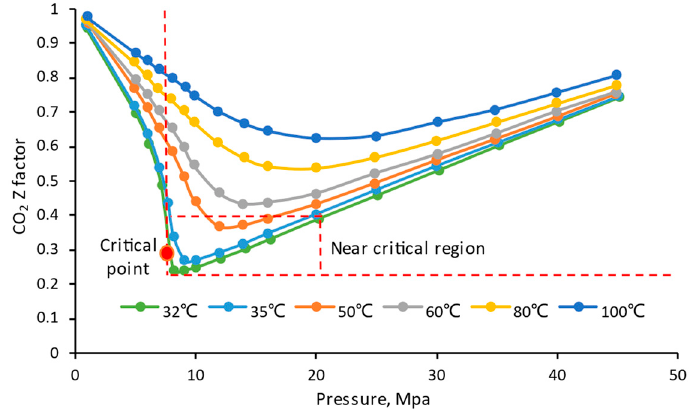
Figure 8. The CO 2 Z factor variation curve under different temperatures and pressures.